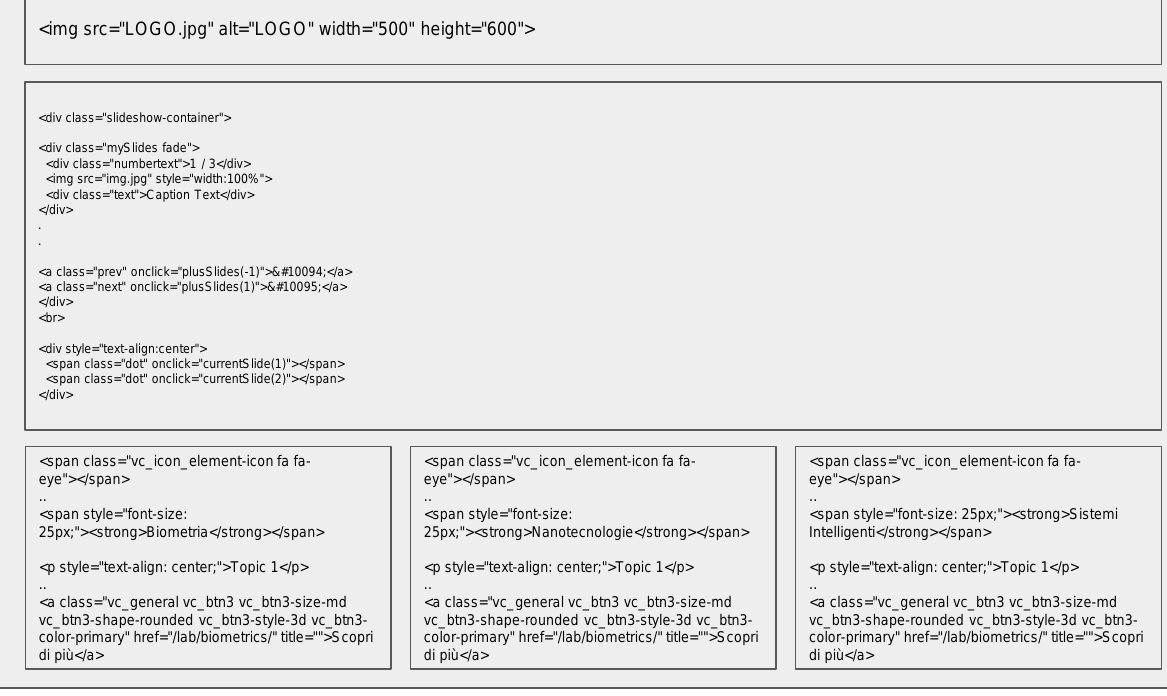
Figure 9. ( a ) Score user: example of the user interface for the scoring provided during his web page navigation. In the example is also reconstructed a mouse hot map, indicating a lot of mouse movements in the red region (in the color scale red is high, orange is average, and yellow is low). ( b ) web page layout structured by tags of Figure 9a.